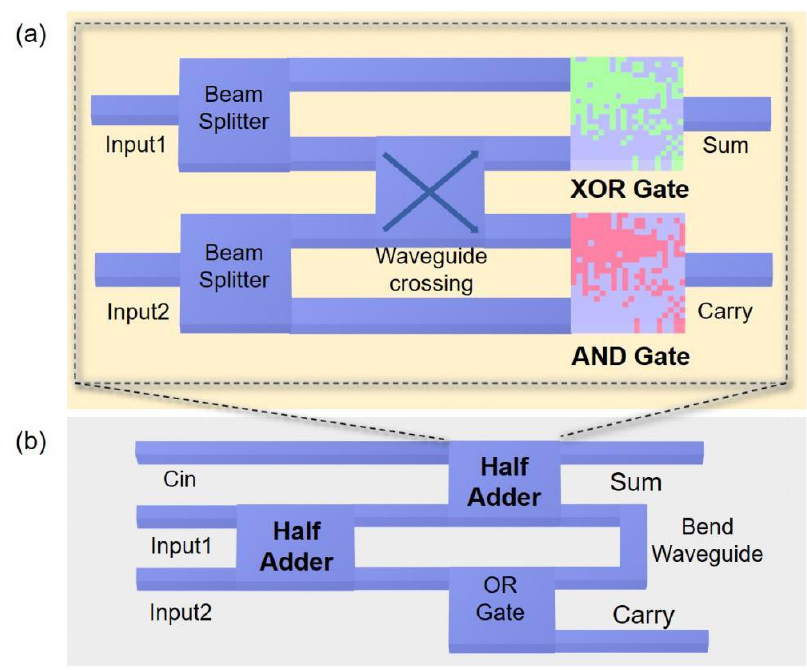
Figure 8. Schematic diagram of half adder and full adder composed of logic gates. ( a ) Half adder composed by two beam splitters, a waveguide crossing, a XOR gate and a AND gate; ( b ) Full adder composed by two half adder and a OR gate.